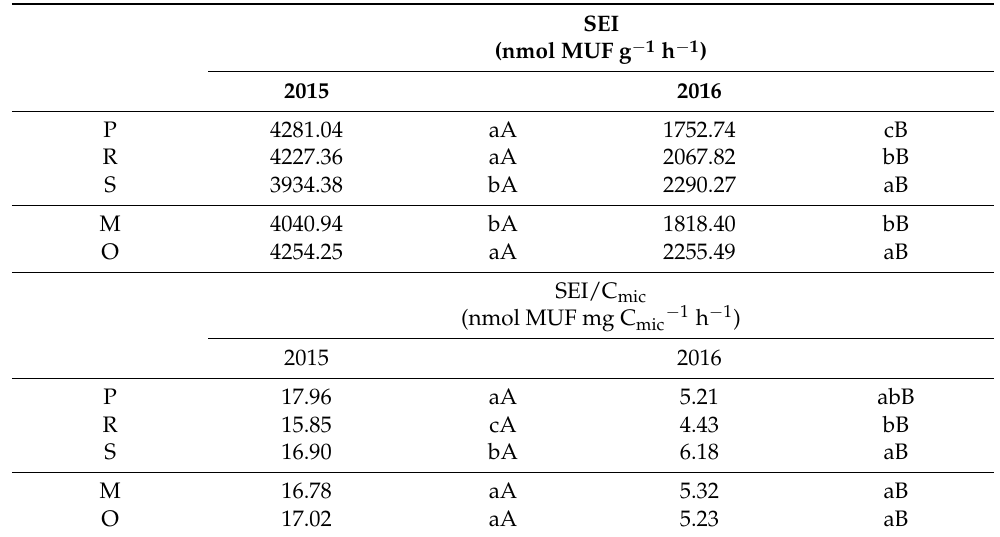
Table 2. Synthetic Enzymatic Index on soil mass base (SEI) and per unit of microbial carbon (SEI/C mic ).